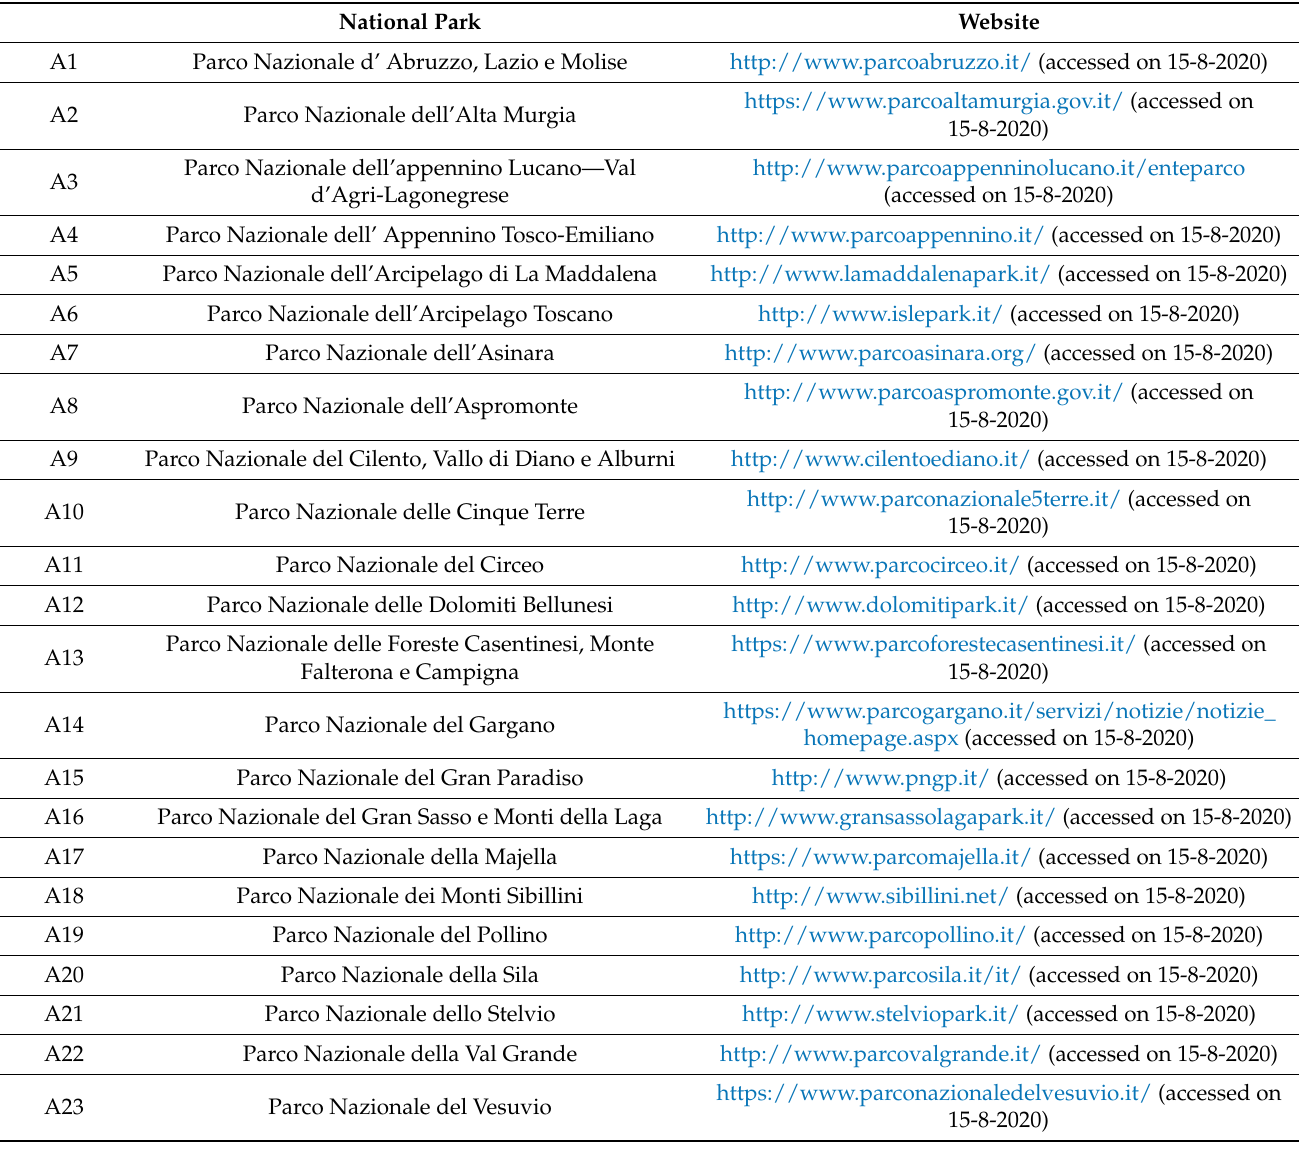
Table 1. The website of NPs in